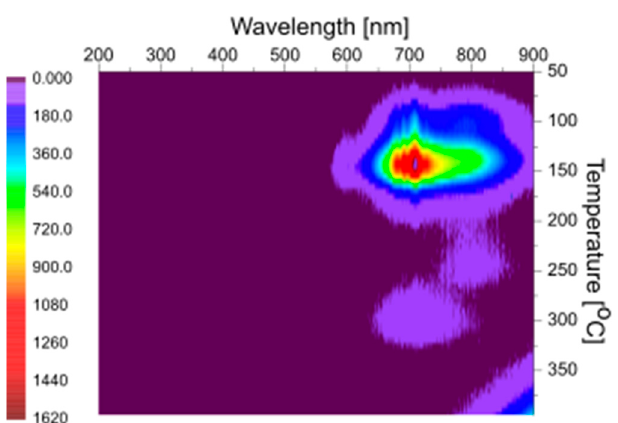
Figure 3. Emission spectra of the YAG substrate after beta-particle irradiation.